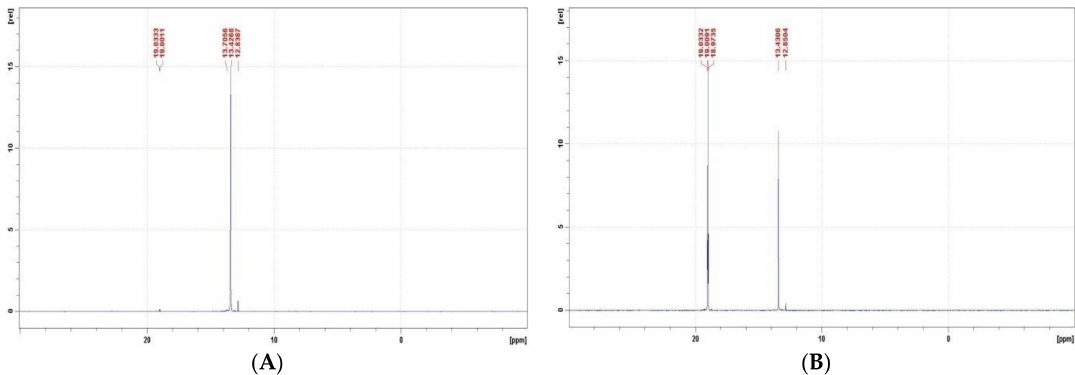
Figure 3. 31 P NMR spectra of Ac-Gly P recorded in 2 M KOH. ( A ) Immediately after mixing the reaction mixture, and ( B ) After 192 h of exposition of the reaction mixture. [Ac-Gly P : 13.4 ppm; Gly P : 19.0 ppm].